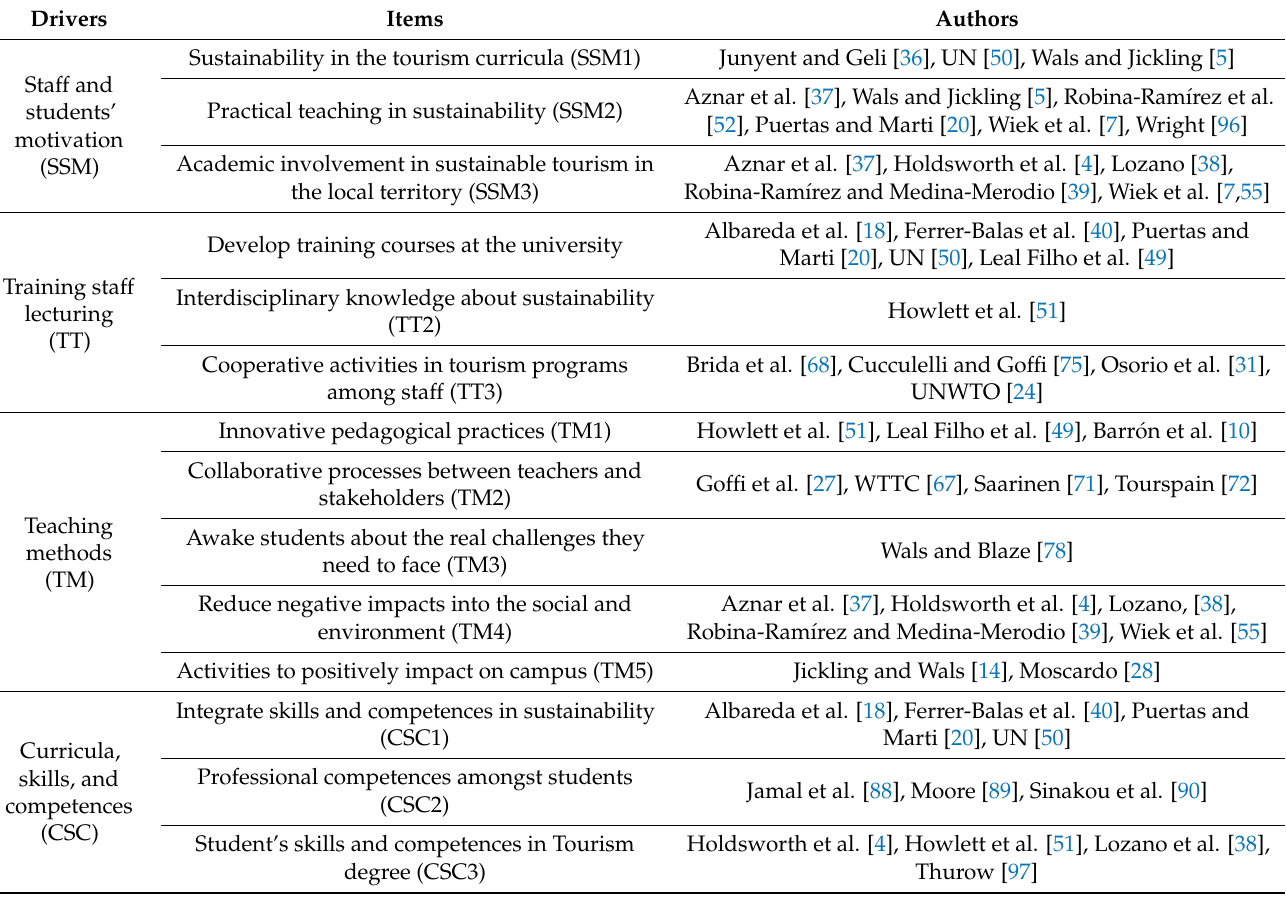
Table 5. Preliminary study and list of